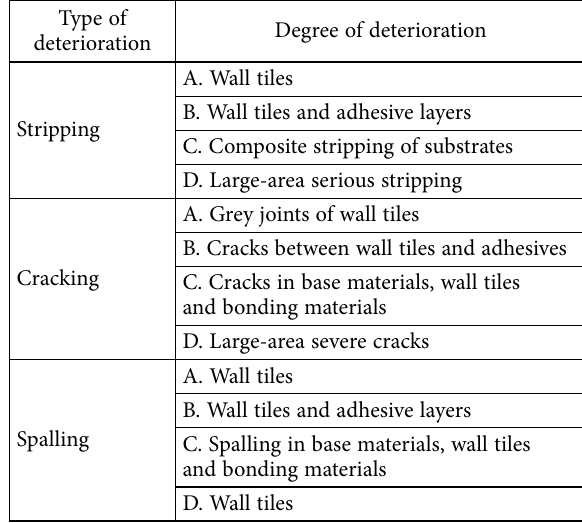
Table 2. Types of exterior walls and causes for deterioration Type of exterior walls Metal curtain wall